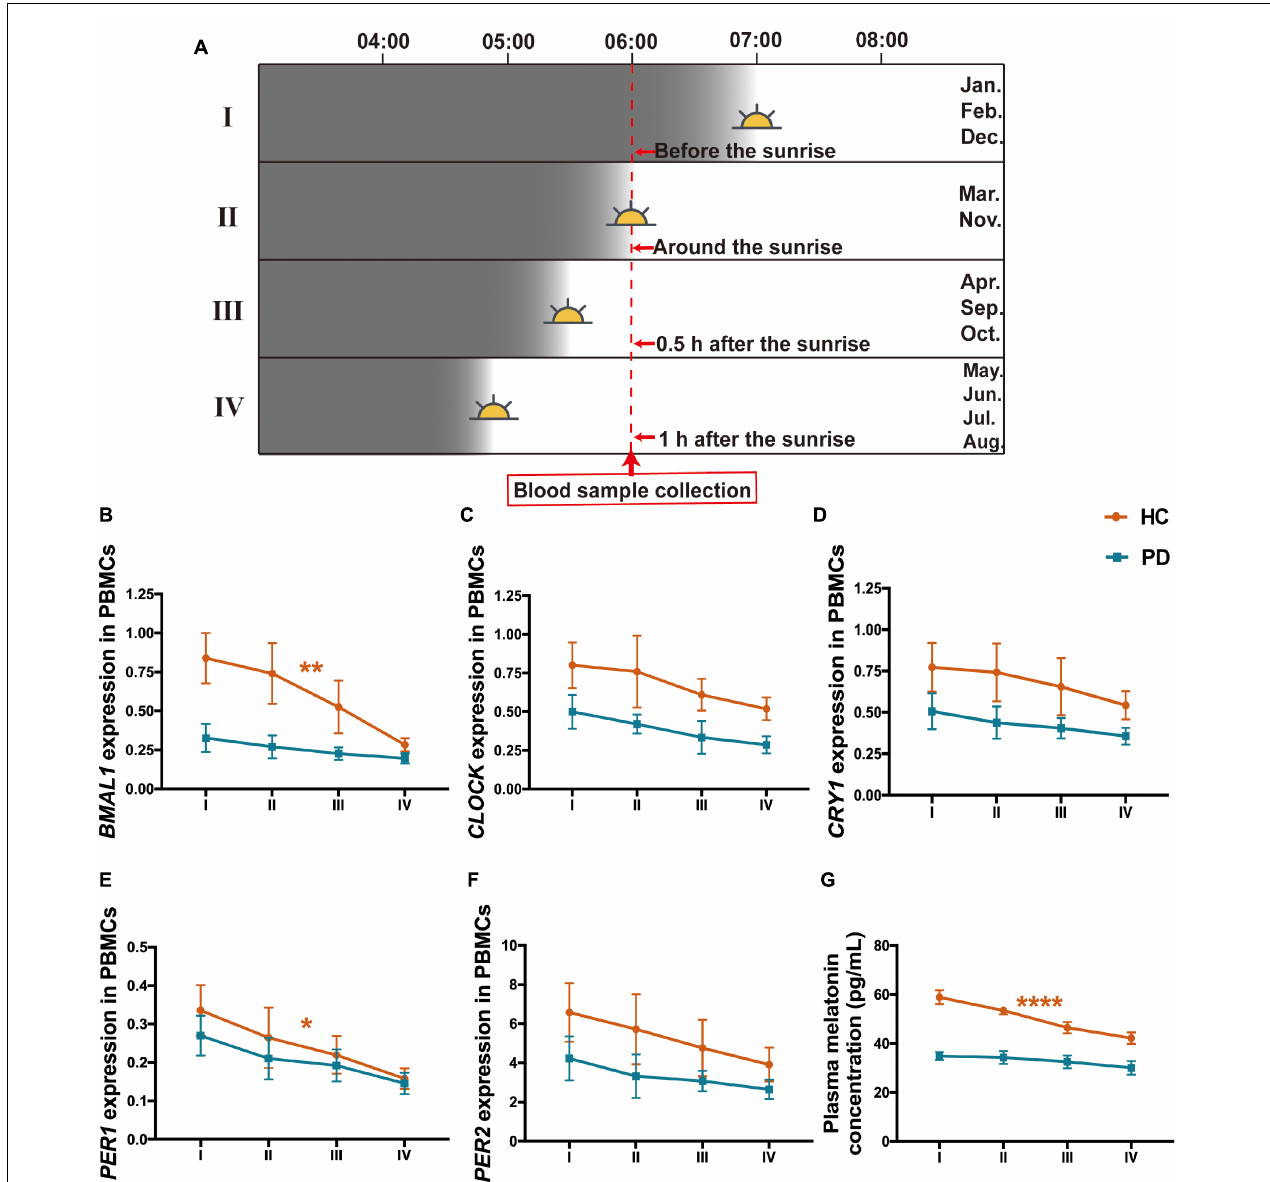
FIGURE 5 | Expression levels of the five clock genes and melatonin in different sunlight intensity of HC and patients with PD. (A) A schematic diagram of the sunlight conditions when sampling in different groups of months. The time of blood sampling from the subjects was fixed at 6–7 a.m. Subjects were divided into 4 groups according to the local sunrise schedule. I: Sampling before the sunrise (January, February, and December, n (HC: PD) = 79: 80); II: Sampling around the sunrise (March and November, n (HC: PD) = 58: 64); III: Sampling 0.5 h after the sunrise (April, September, and October, n (HC: PD) = 57: 63); IV: Sampling 1 h after the sunrise (May, June, July, and August; n (HC: PD) = 120: 119). (B–F) PBMCs levels of BMAL1 (B) , CLOCK (C) , CRY1 (D) , PER1 (E) , and PER2 (F) expression in the group of PD and HC, with different intensities of sunlight. (G) Plasma melatonin concentration in PD and HC with different intensities of sunlight. The results are the mean ± SEM values. * P < 0.05, ** P < 0.01, and **** P <